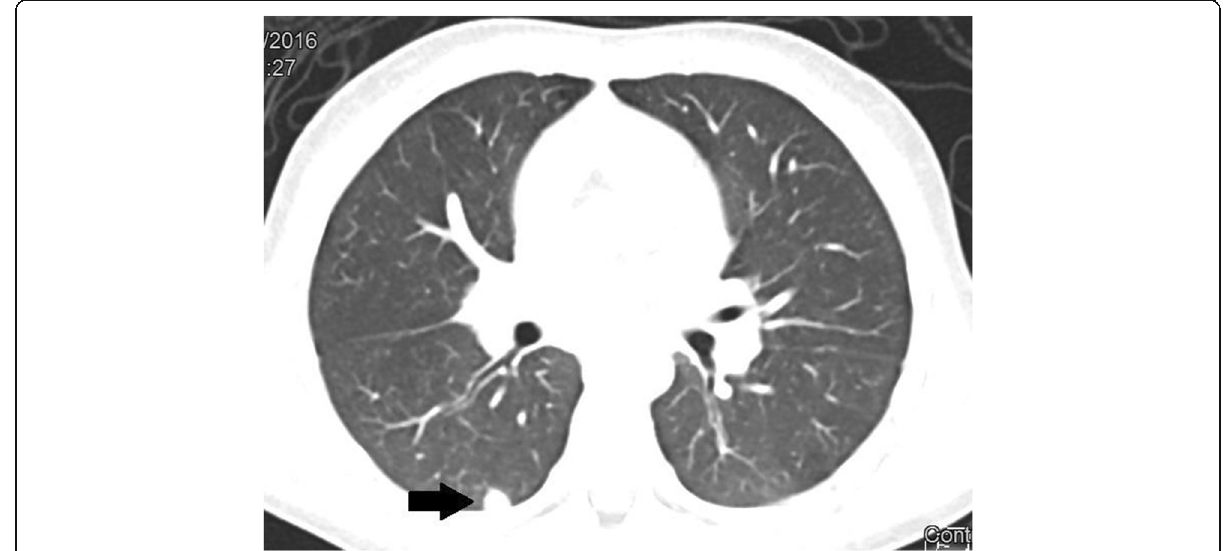
Fig. 3 Lesion initially suspected to metastasis in child with nephroblastoma, diagnosed with tuberculosis on